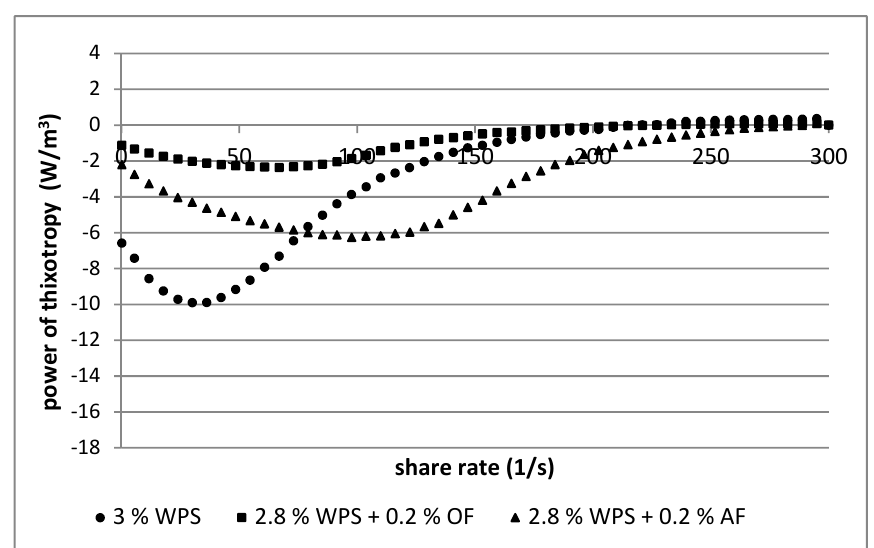
Figure 5. Relationship between the power of thixotropy in a volume of the sample at a defined shear rate and the shear rate in 3% ( w / w ) starch pastes and their 3% mixtures (2.8% starch with 0.2%dietary fibers). Waxy potato starch (WPS), oat fiber (OF), apple fiber (AF). Polymers 2020 , 12 , 321